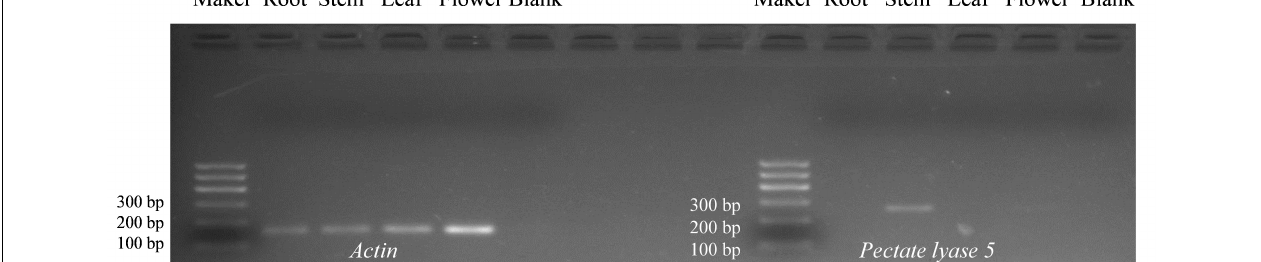
FIGURE 8 | Alignment of Pectate lyase 5 amino acid sequence (A) and the tissue specific expression of Pectate lyase 5 (B) . Red letters indicate the different amino acid sequences between WT and lazy1. Blue lines are the locations of pbH domains.